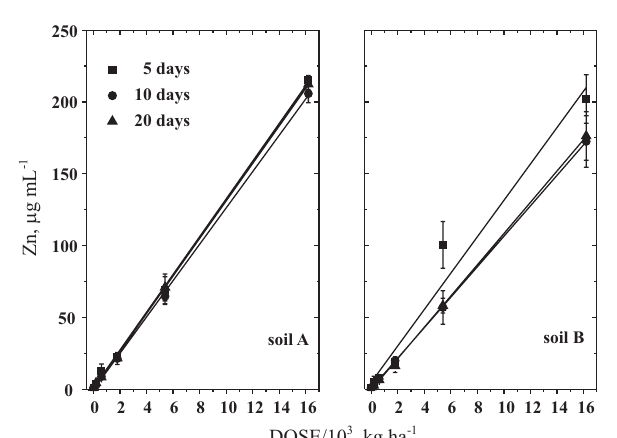
Figure 5. Zinc extractability under increasing doses of solid residue in soils A and B. Table 3 shows the fitted parameter values according to the algebraic model adjusted for Zn response.